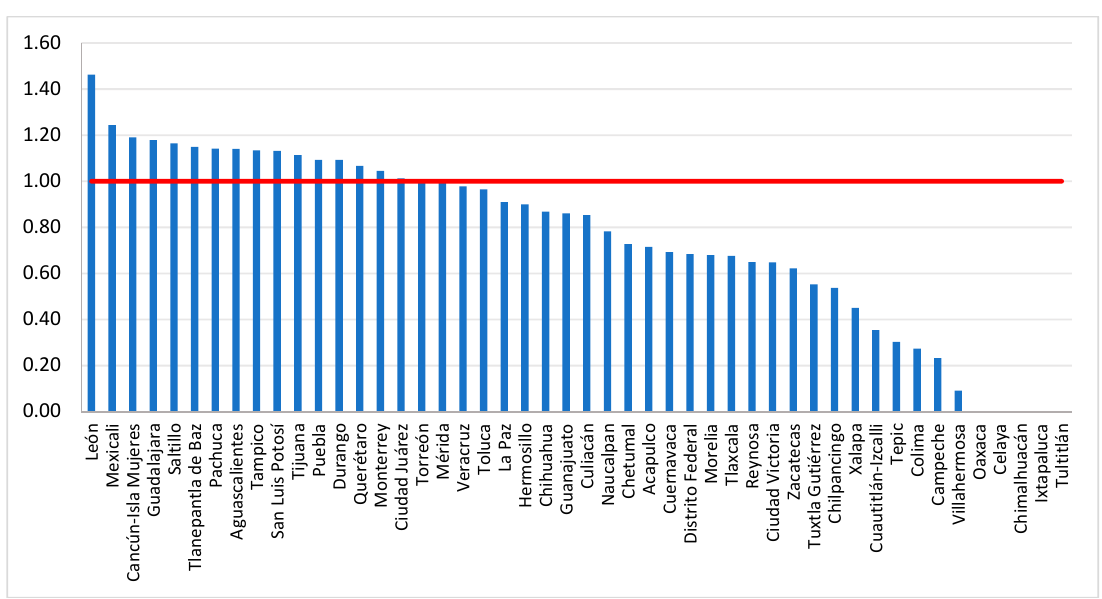
Figure 5. Coefficient (ratio) revenues/expenditure in water utilities, selected cities. Source: CCA [24]; Quadri de la Torre [10]. Note: The cities of Ecatepec de Morelos and Cd. Nezahualcóyotl have been left out if this graph as their coefficient numbers are outliers which cannot be properly explained.